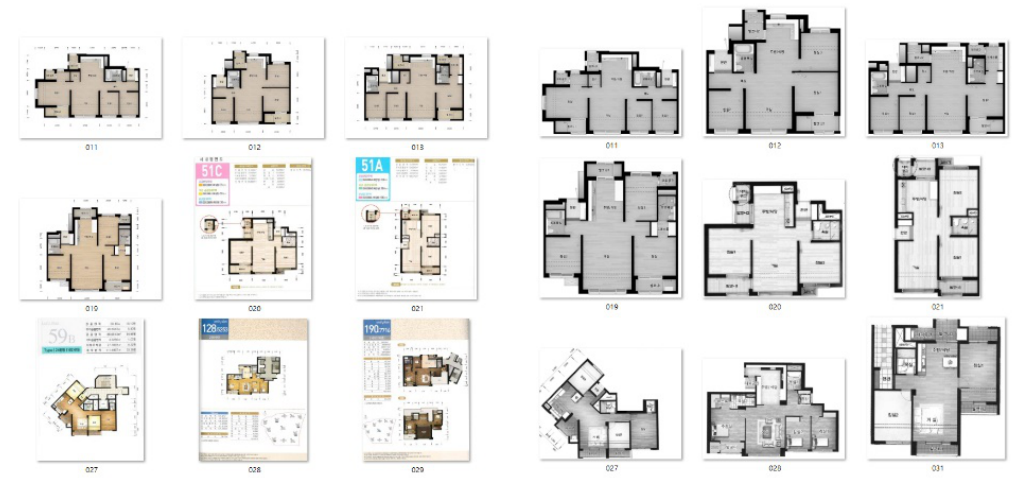
Figure 5. Before and after image preprocessing.